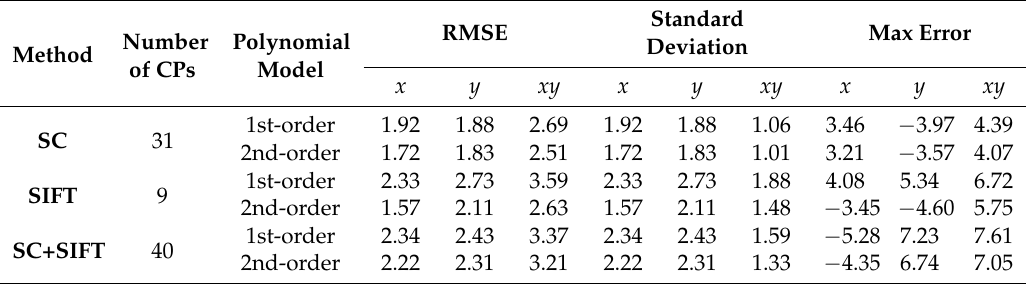
Table 1. Quantitative Results of Control